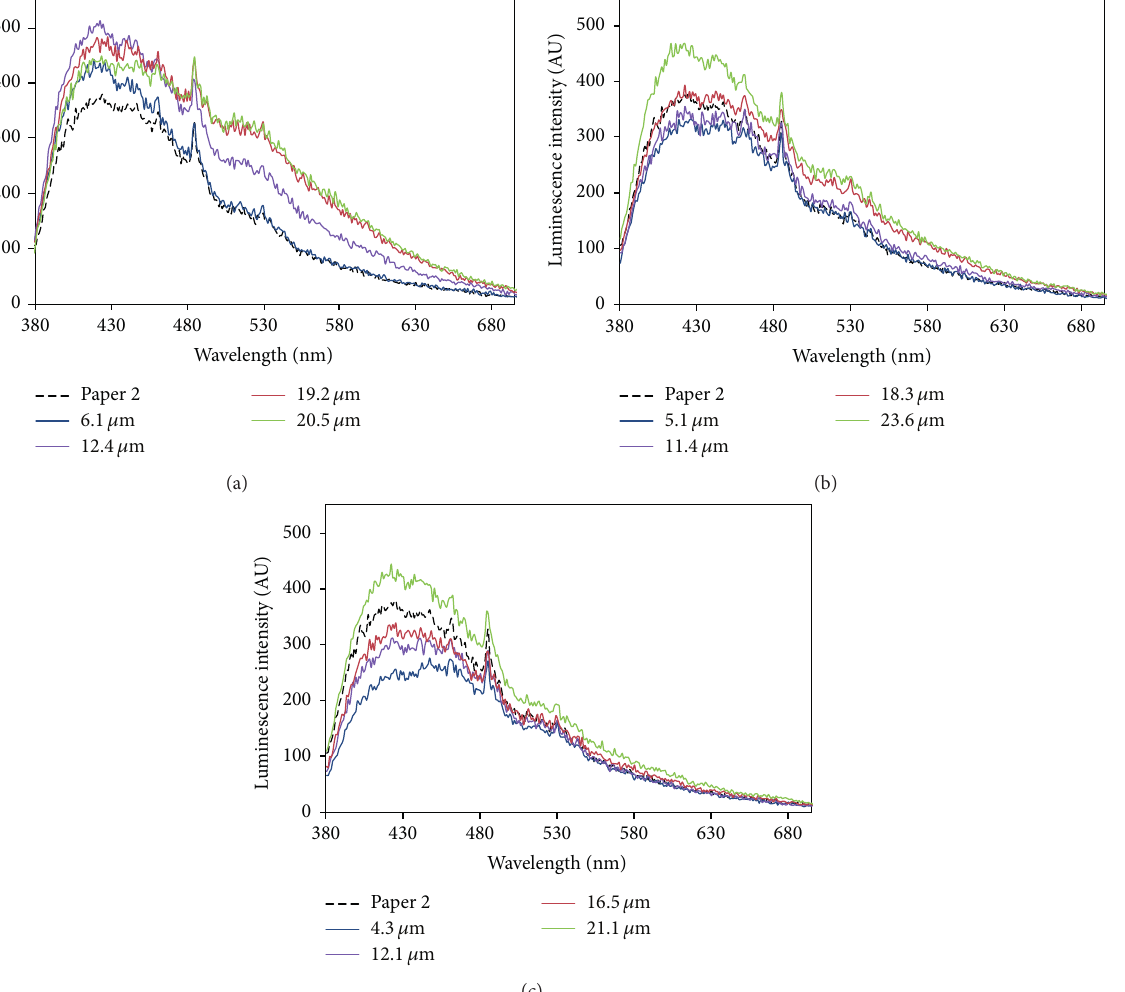
Figure 7: The luminescence spectra of images printed onto the paper with the medium content of OBAs (paper 2) and ink compositions with the following contents of the fluorescent component (ZnO nanoparticles): (a) 0.15%; (b) 0.1%; (c)